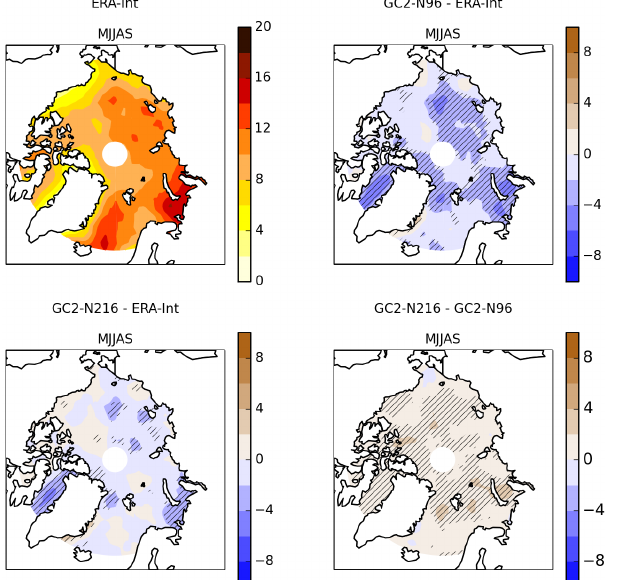
Figure 2. MSLP-based tracking – multi-annual MJJAS mean cy- clone track density (10 − 6 km − 2 month − 1 ): ERA-Interim, GC2- N96 minus ERA-Interim, GC2-N216 minus ERA-Interim and GC2- N216 minus GC2-N96. ERA-Interim uses the 1990–2009 MJJAS mean, while GC2-N96 and GC2-N216 use the MJJAS mean over the last 100 years of the 150-year run. Hatching indicates that the difference is shown by Welch’s t test to be statistically significant at the 95%